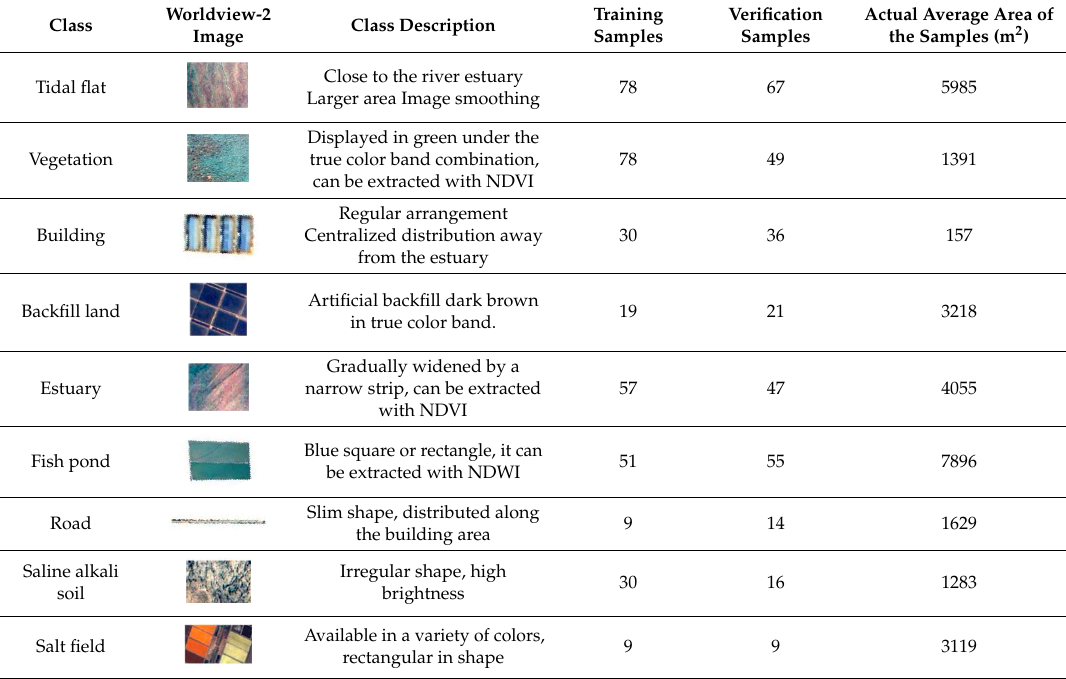
Table 3. Class description training samples and verification samples in the Landsat-8 images.